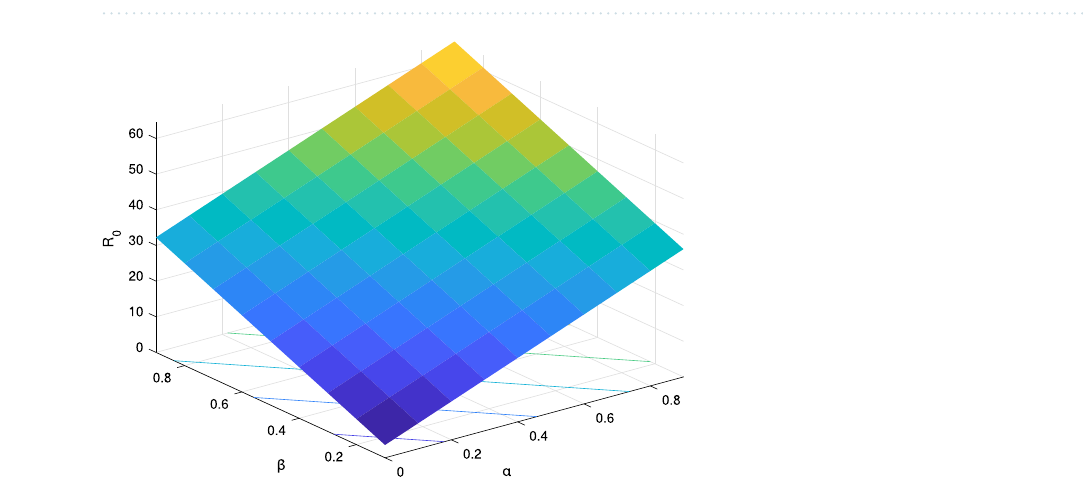
Figure 8. The sensitivity analysis of the basic reproduction number R 0